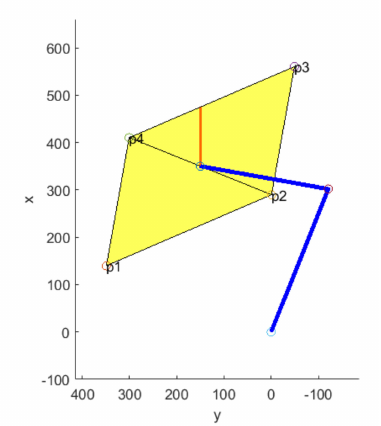
Figure 4. KDI computed for the SCARA robot in point P (350, 150) along any horizontal direction.